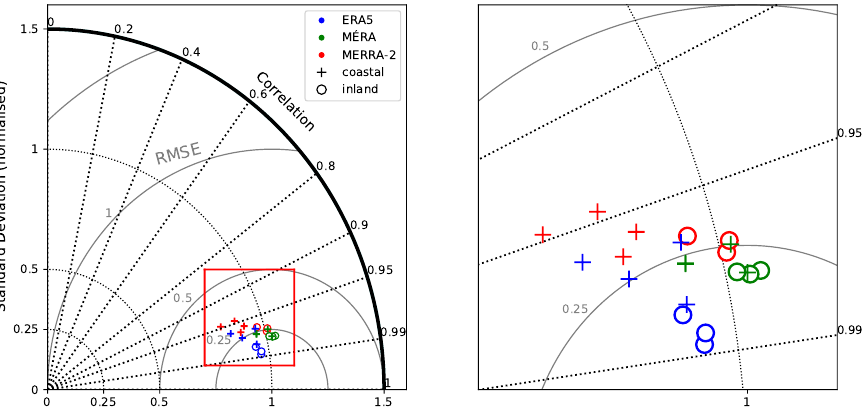
Figure 4. Left : Taylor diagram of 2 m temperature at all stations (coastal (+) and inland (o)) for ERA5 ( blue ), MÉRA ( green ), and MERRA-2 ( red ). The radial dimension represents the model normalised standard deviations, correlation coefficients are represented in angular coordinates and the arcs show the normalised centred RMSE (CRMSE). Right : close-up view of the red box in left